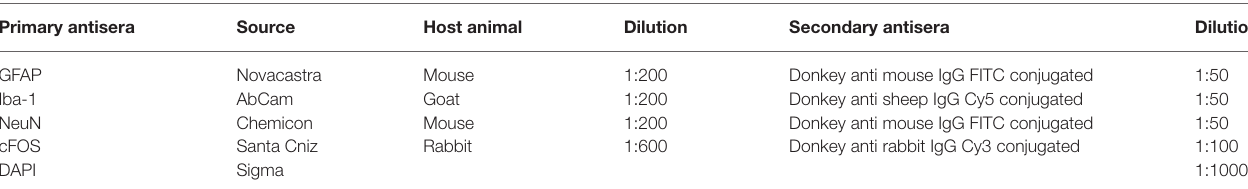
TABLE 2 | Primary and secondary